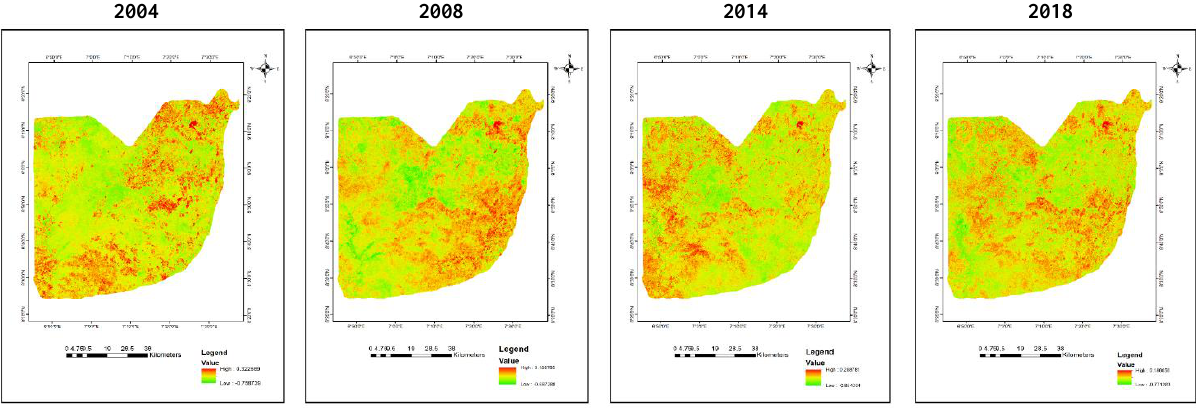
Figure 5. Spatial distribution of the NDVI in 2004, 2008, 2014 and 2018.